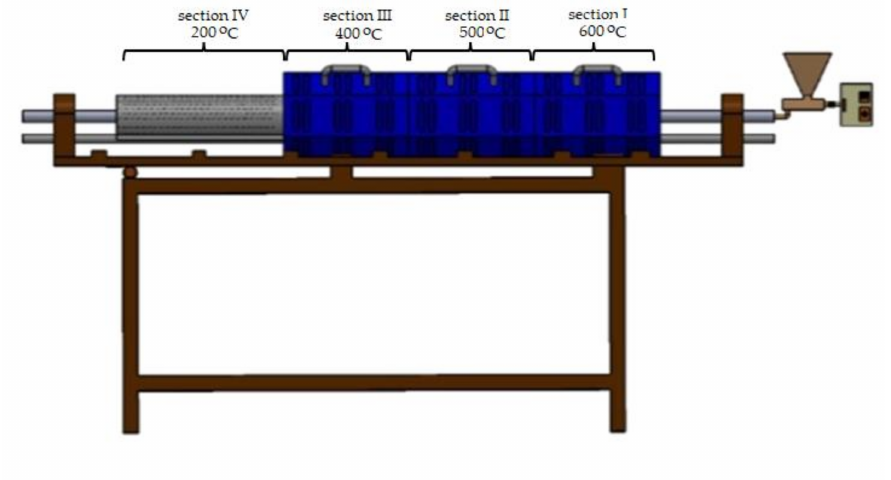
Figure 1. Rotary kiln for pyrolysis process.